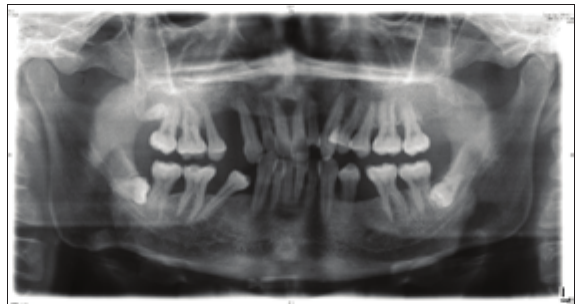
Figure 6. Panoramic radiograph at month 13 of treatment progress.